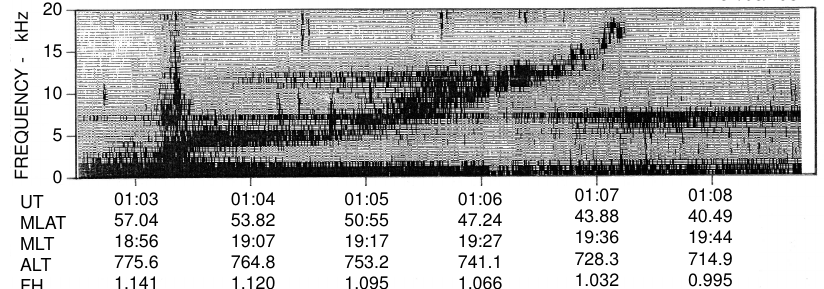
Fig.1 Morioka et al.